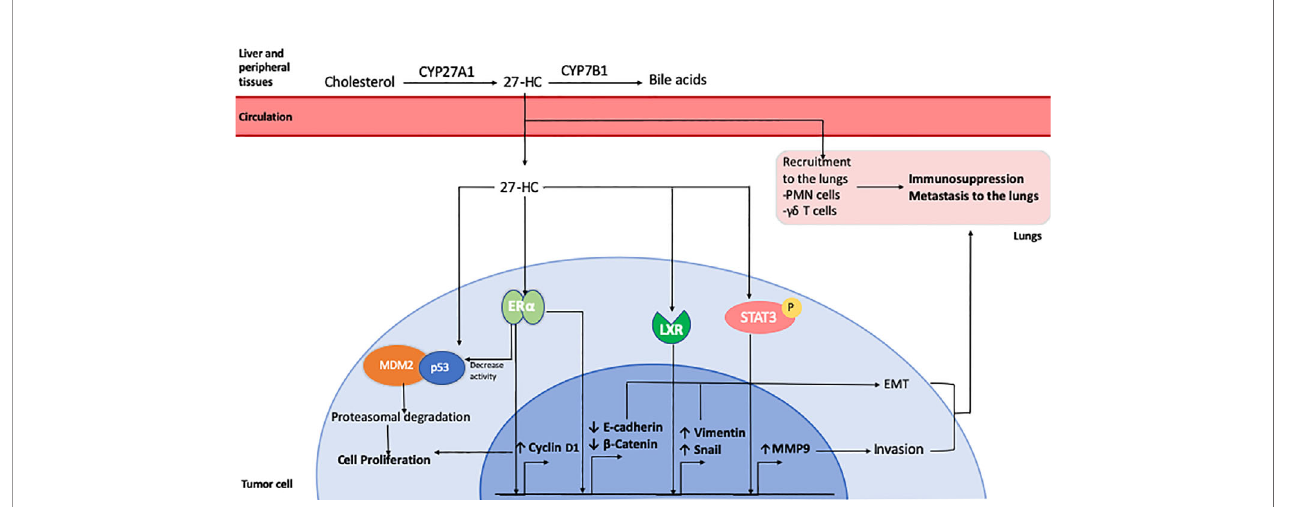
FIGURE 2 | Role of 27-Hydroxycholesterol in breast cancer. 27-HC is synthesized from cholesterol by CYP27A1 in the liver and other peripheral tissues. It can be further metabolized for bile acid synthesis by CYP7B1. 27-HC can be taken up by tumor cells from the circulation where it exerts ER a agonistic activity, inducing the expression of Cyclin D1 which leads to cell cycle progression and proliferation. It can also enhance the association of tumor suppressor p53 protein with MDM2 leading to its degradation. 27-HC has also been shown to promote EMT by reducing E-Cadherin and b -Catenin expression and by inducing an LXR-mediated increase in Snail and Vimentin expression. It can also activate Stat3 signaling, resulting in increased expression of MMP9 and cell invasion. 27-HC in the lungs can promote the recruitment of polymorphonuclear cells and T cells which favors the development of an immunosuppressive microenvironment that facilitates metastatic seeding and growth of breast cancer